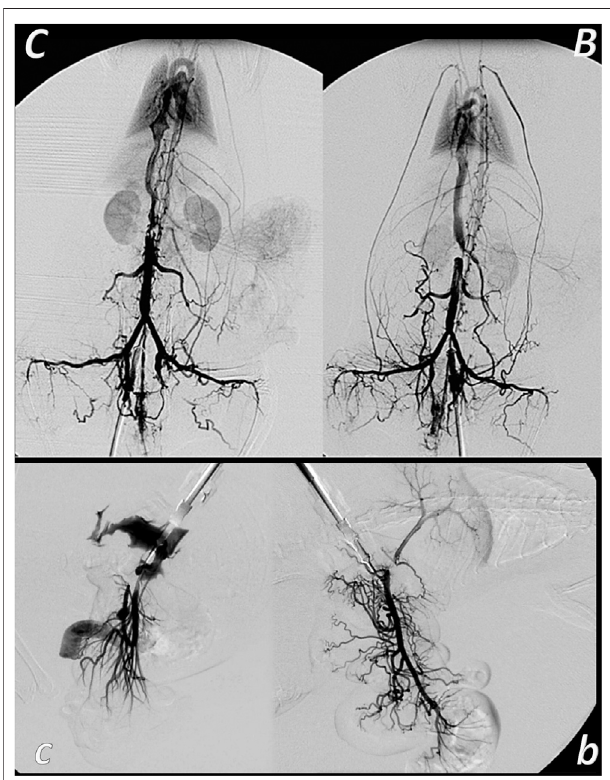
FIGURE7| VenousocclusionandBPC157therapy.GivenBPC157(as an abdominal bath) immediately before venography, at a particular point, venography demonstrated a rapid recruitment of the collaterals to bypass occlusion and reestablish blood fl ow. In the rats with infrarenally occluded inferior caval vein, venography in the inferior caval vein below the ligation shows that the left ovarian vein is rapidly presented as the major pathway. The other veins (such as epigastric veins, intercostal veins, mammary veins, iliolumbar veins, paraumbilical vein, azygos vein, and right ovarian vein) accordingly appear in BPC 157 rats ( B ), unlike in controls ( C ). Together, this means rapidly activated ef fi cient compensatory pathways and the ligation-stop at the inferior caval vein ef fi ciently bypassed (Vukojevic et al., 2018). Both kidneys and canal systems and con fl uence of the inferior caval vein to the right heart demonstrated that redistribution of otherwise trapped blood volume was rapidly achieved (Vukojevic et al., 2018). In the rats with occluded superior mesenteric vein, occlusion was made at the end of the superior mesenteric vein. Venography in superior mesenteric vein below the ligation shows that bypassing through inferior anterior pancreaticoduodenal vein and superior anterior pancreaticoduodenal vein to the pyloric vein toward the portal vein rapidly occurs in BPC 157 rats ( b ), unlike failed bypassing presentation in controls with occluded superior mesenteric vein ( c ).